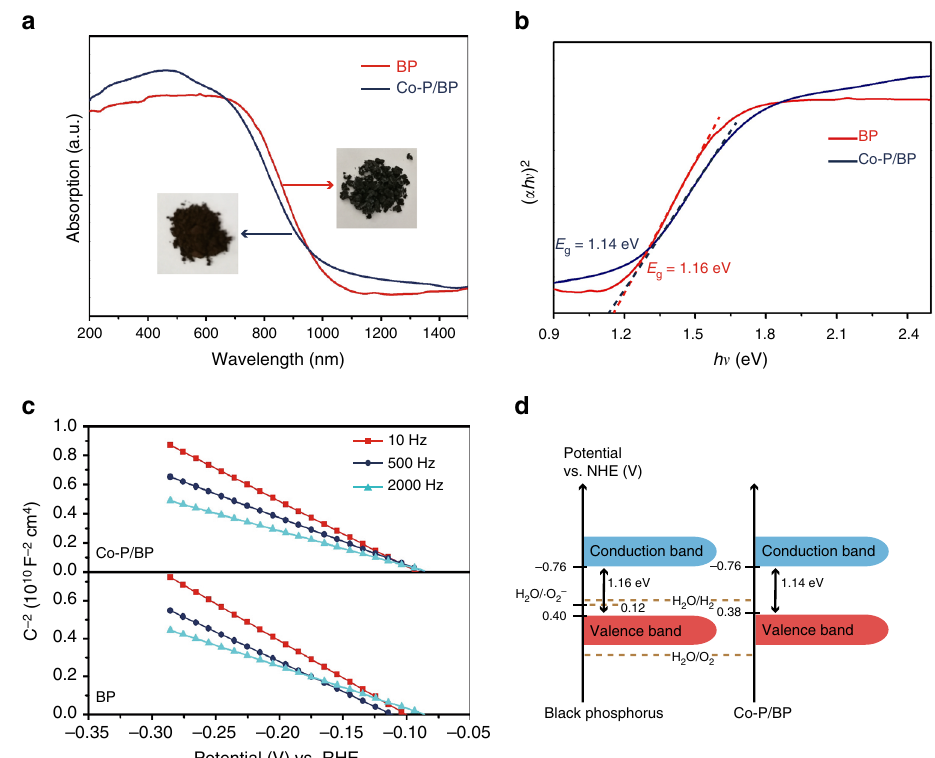
Fig. 3 Bandgap states of the as-prepared BP-based samples. a UV – vis – NIR absorption spectra of the BP (red curve) and Co-P/BP (navy curve) nanosheets. The inset is digital photographs of the as-prepared samples. b ( ah ν ) 2 vs. h ν curve for BP (red curve) and Co-P/BP (navy curve) nanosheets. The dashed lines are the tangents to the curves. The intersection value is the bandgap. c Mott – Schottky plots for the BP and Co-P/BP nanosheets from impedance measurements. The fl at-band potentials were obtained from the intercepts of the extrapolated lines. d Band positions of the BP and Co-P/BP nanosheets from the bandgaps and fl at-band potentials obtained from Fig.